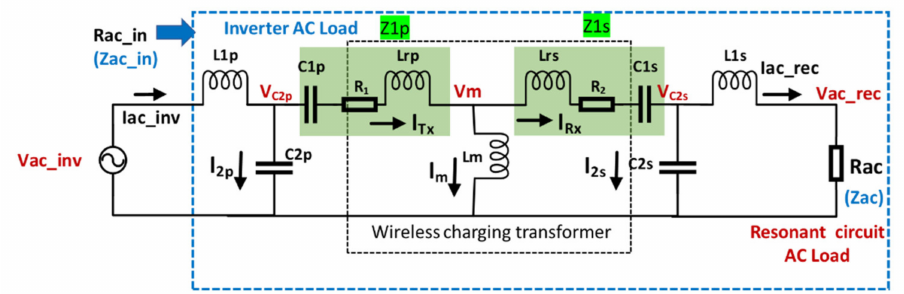
Figure 4. Equivalent LCC AC resonant circuit with detailed wireless charging transformer